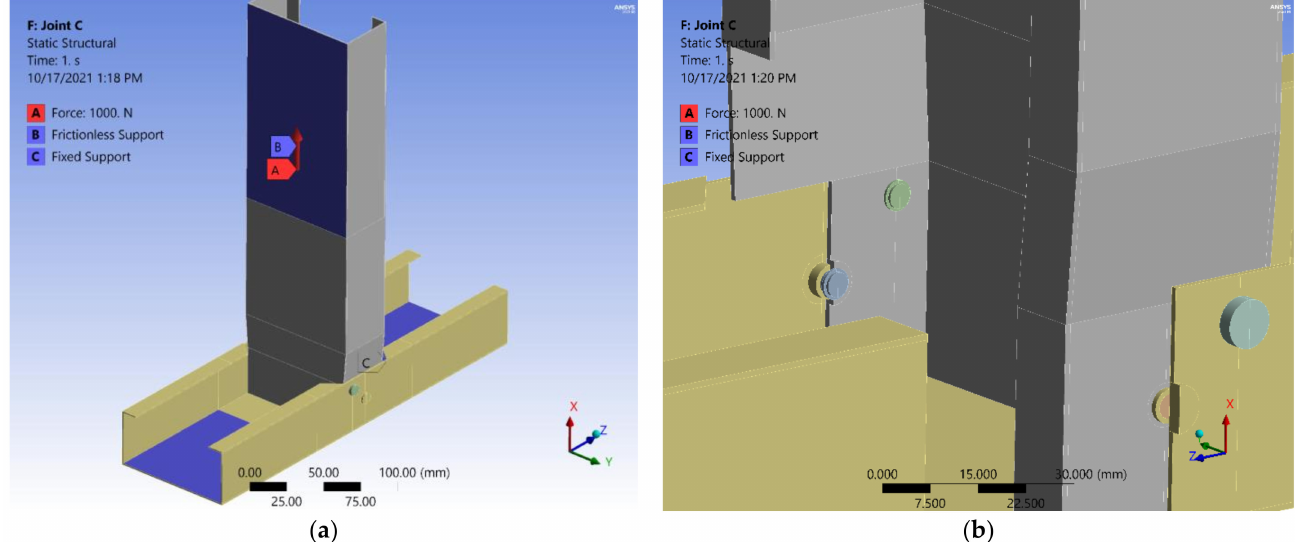
Figure 32. Joint C: ( a ) overall; ( b ) details of screws with hidden